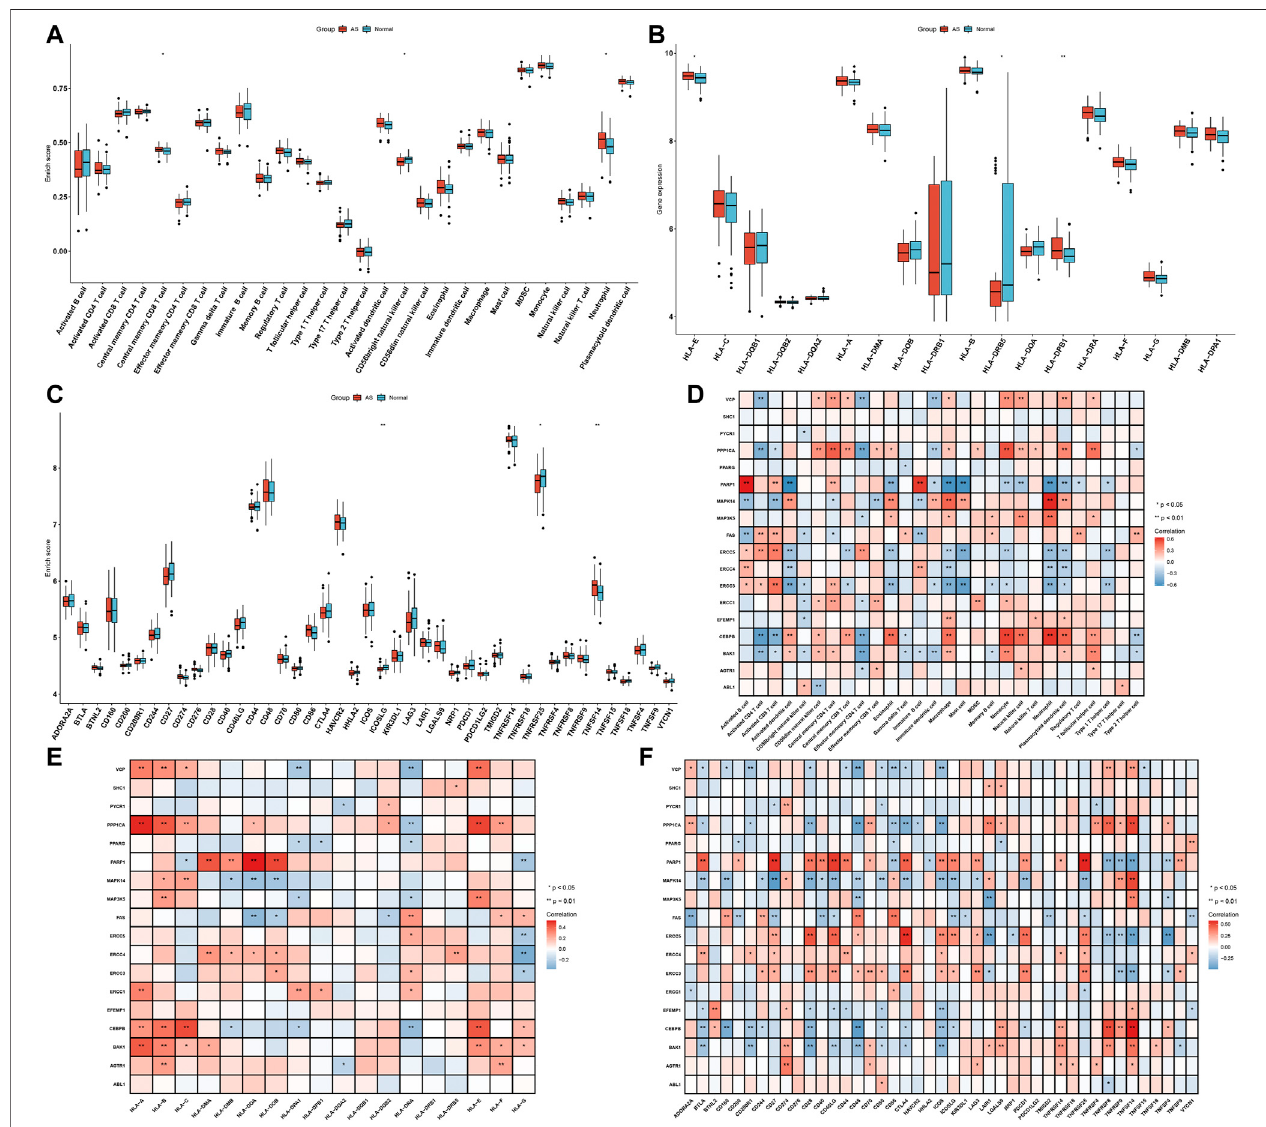
FIGURE 3 | Feature aging-related gene signatures associated with immune in fi ltrations in AS. (A) Box plots showing the differences in immune cell in fi ltrations between AS and non-AS samples. (B,C) Box plots of the mRNA expression of HLA molecules and immune checkpoints in AS and non-AS samples. (D – F) Heatmaps visualizing the associations of feature aging-related gene signatures with immune cell in fi ltrations and mRNA expression of HLA molecules and immune checkpoints across AS samples. * p < 0.05; ** p < 0.01.